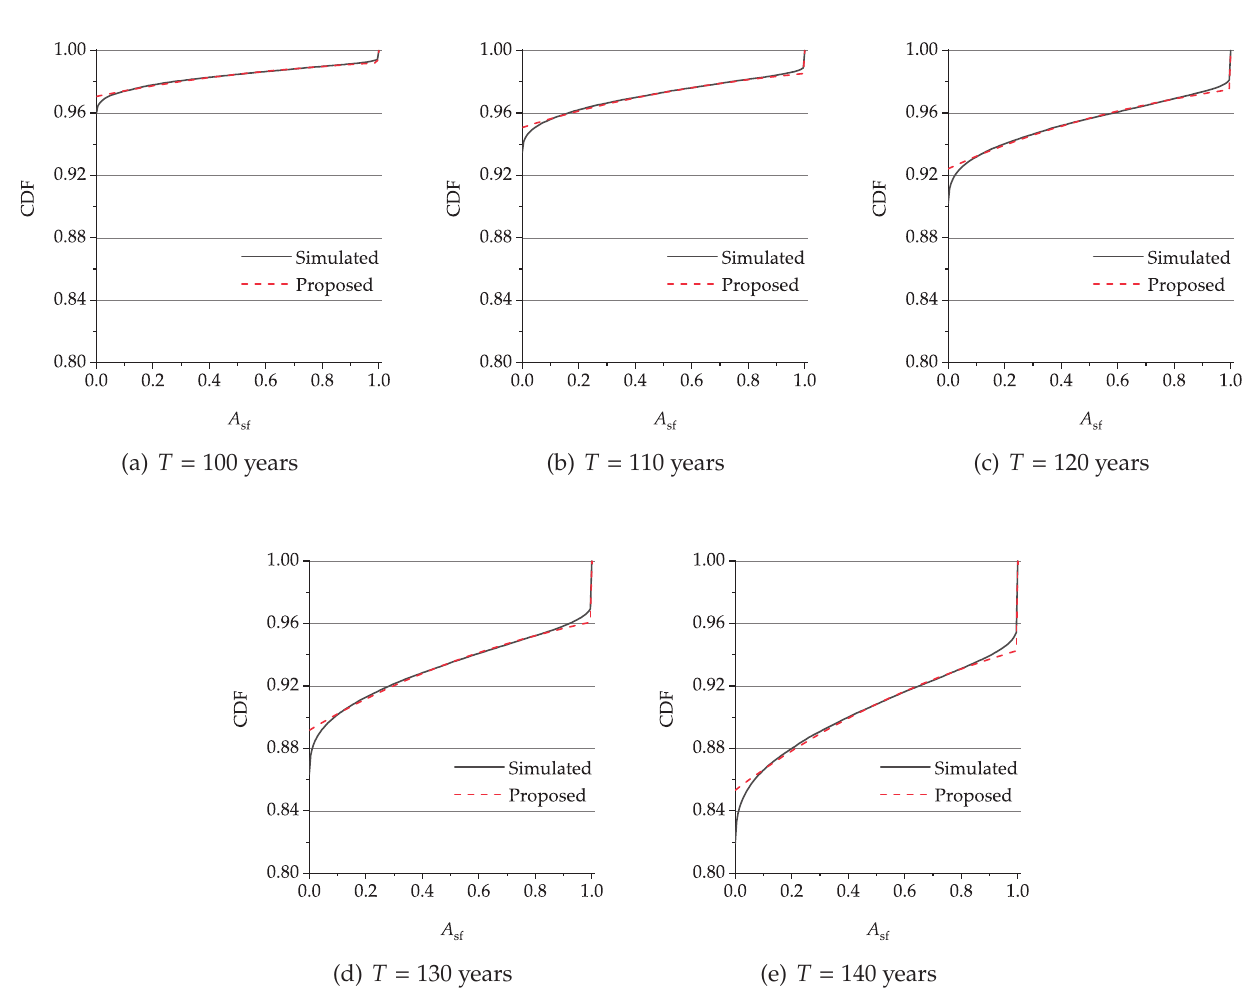
Figure 7. CDFs of A sf ( t ) by the proposed and simulation-based methods ( µ ( x 0 ) = 90